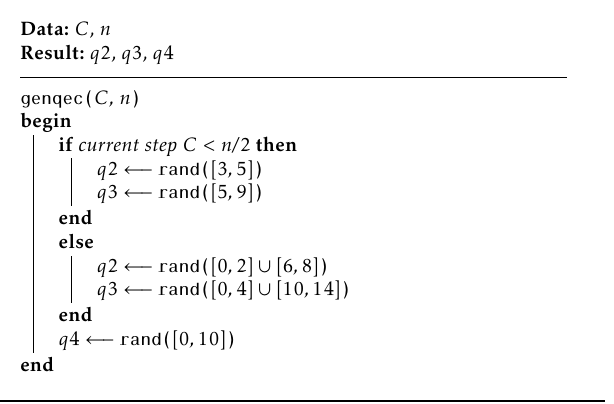
Table 6. Side-channel programs for transitions among S Target